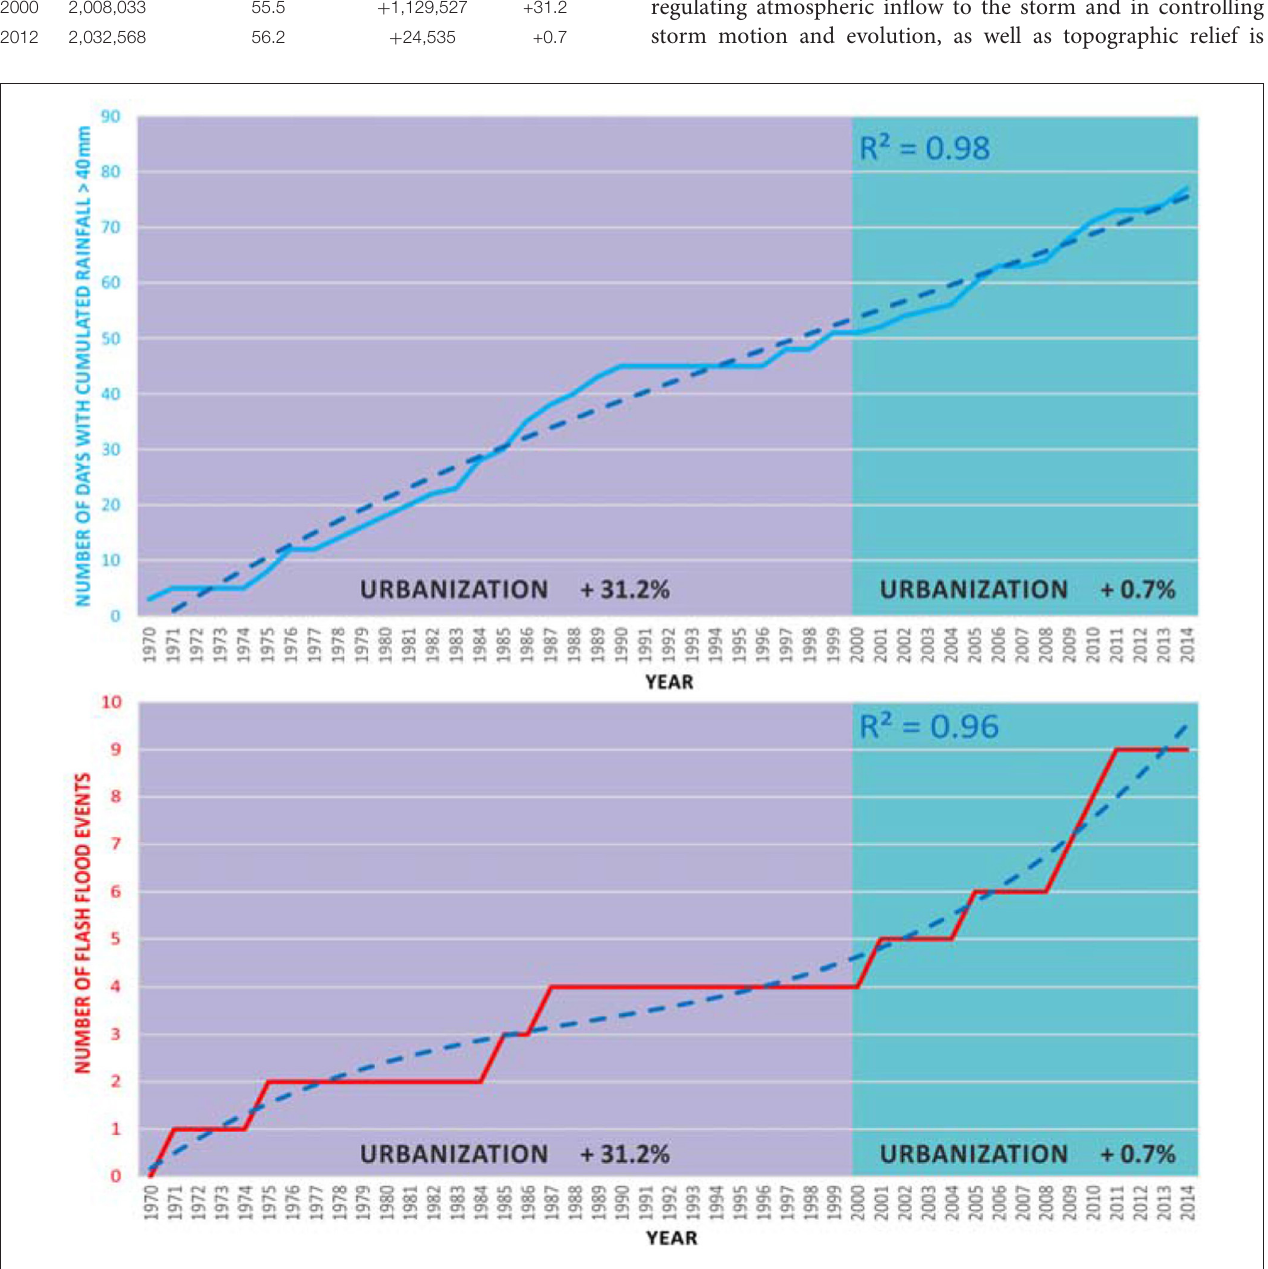
FIGURE 12 | Trend of days characterized by a cumulative rainfall depth ≥ 40mm (above) and trend of flash flood events (below) related to the 1970–2014 time interval. Urbanization rates are also reported for comparison